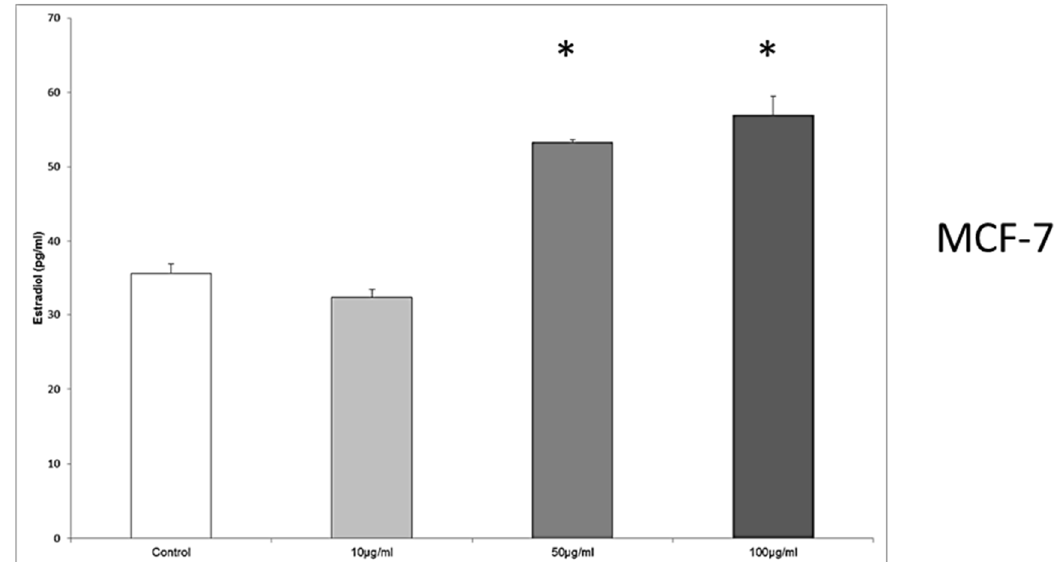
Figure 8. Estradiol concentration in the tissue culture medium of JEG ‐ 3, BeWo and MCF7 cells in the absence or presence of enterodiol. The effective enterodiol concentrations were 50 μ g/mL and 100 μ g/mL. Significantly different observation are highlighted with an asterisk.